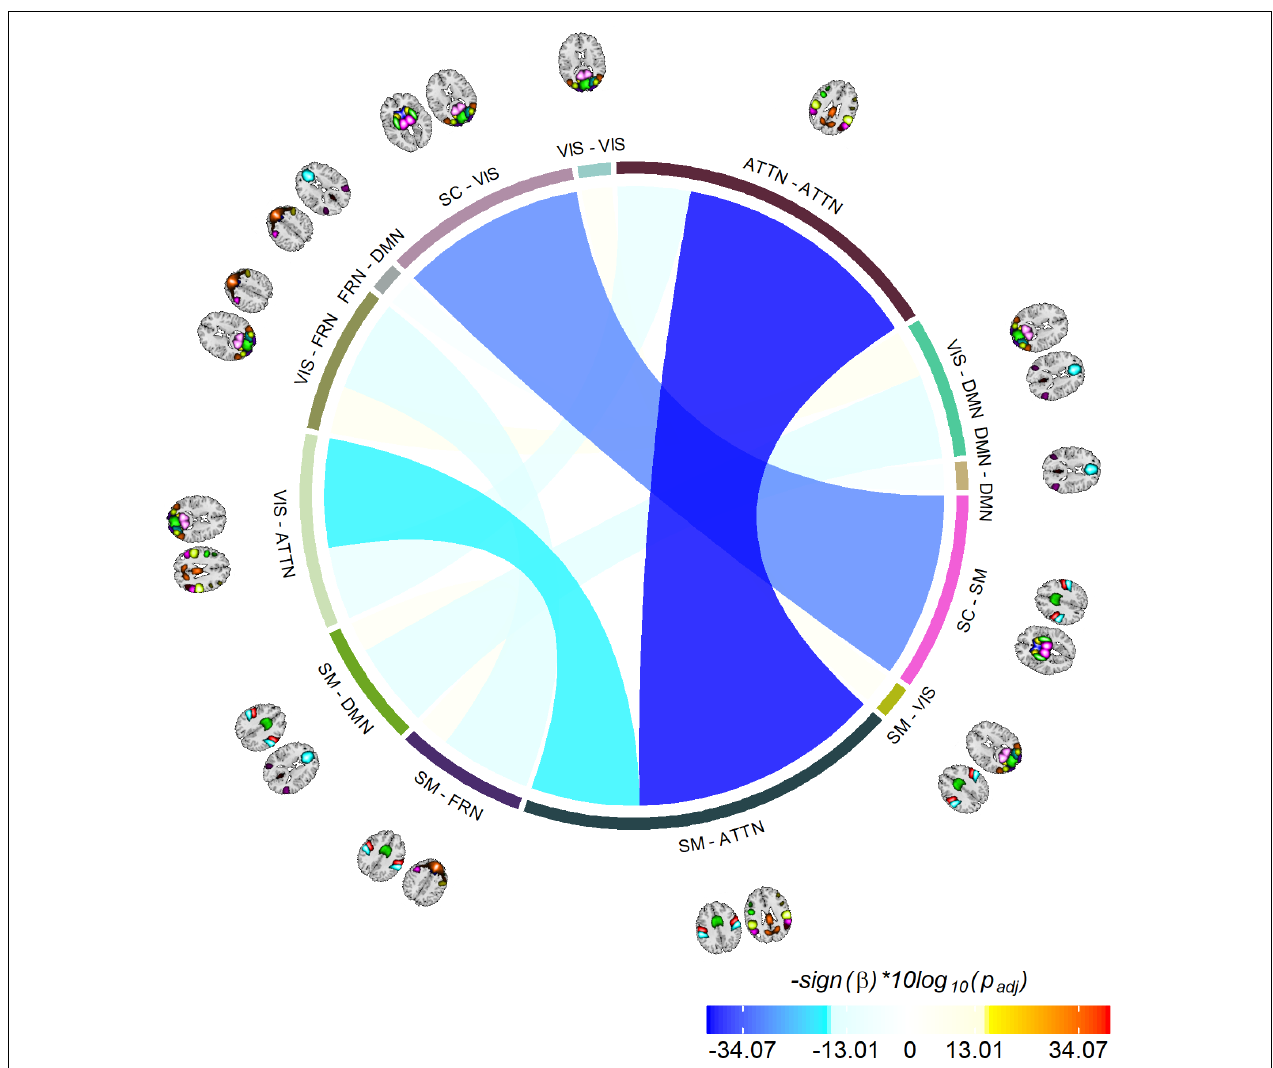
FIGURE 6 | Significant group differences between HCs and SZs. Showing 10 CDMI between 13 different pairs of DFDC which had significantly high CDMI value (determined via bootstrapping). The color of the links indicates sign ( β ) and the width indicates sign ( β ) × | log10 ( p ) | , where β is the regression slope and p is the p -value corresponding to the diagnosis variable corrected using FDR correction for multiple comparisons. Negative β values indicate decreased CDMI in SZs, with the three darkest/widest links showing the pairs of DFDC which show significant group difference in CDMI at p < 0.05